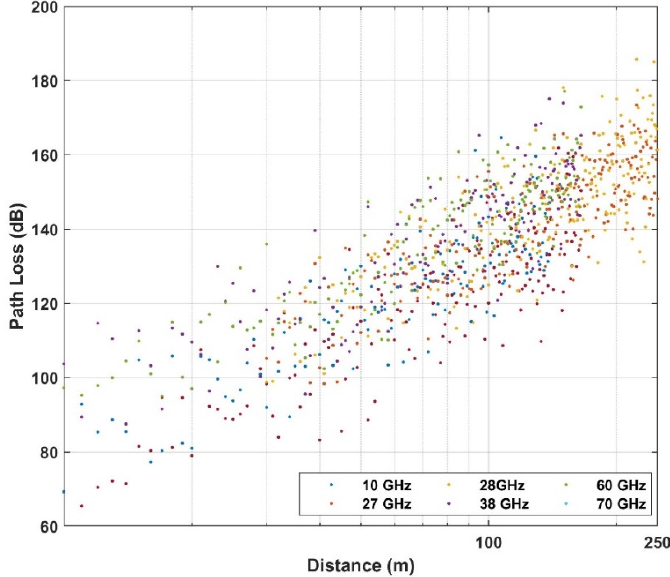
Figure 4. Empirical path loss at below rooftop in an urban low-rise (suburban) environment.